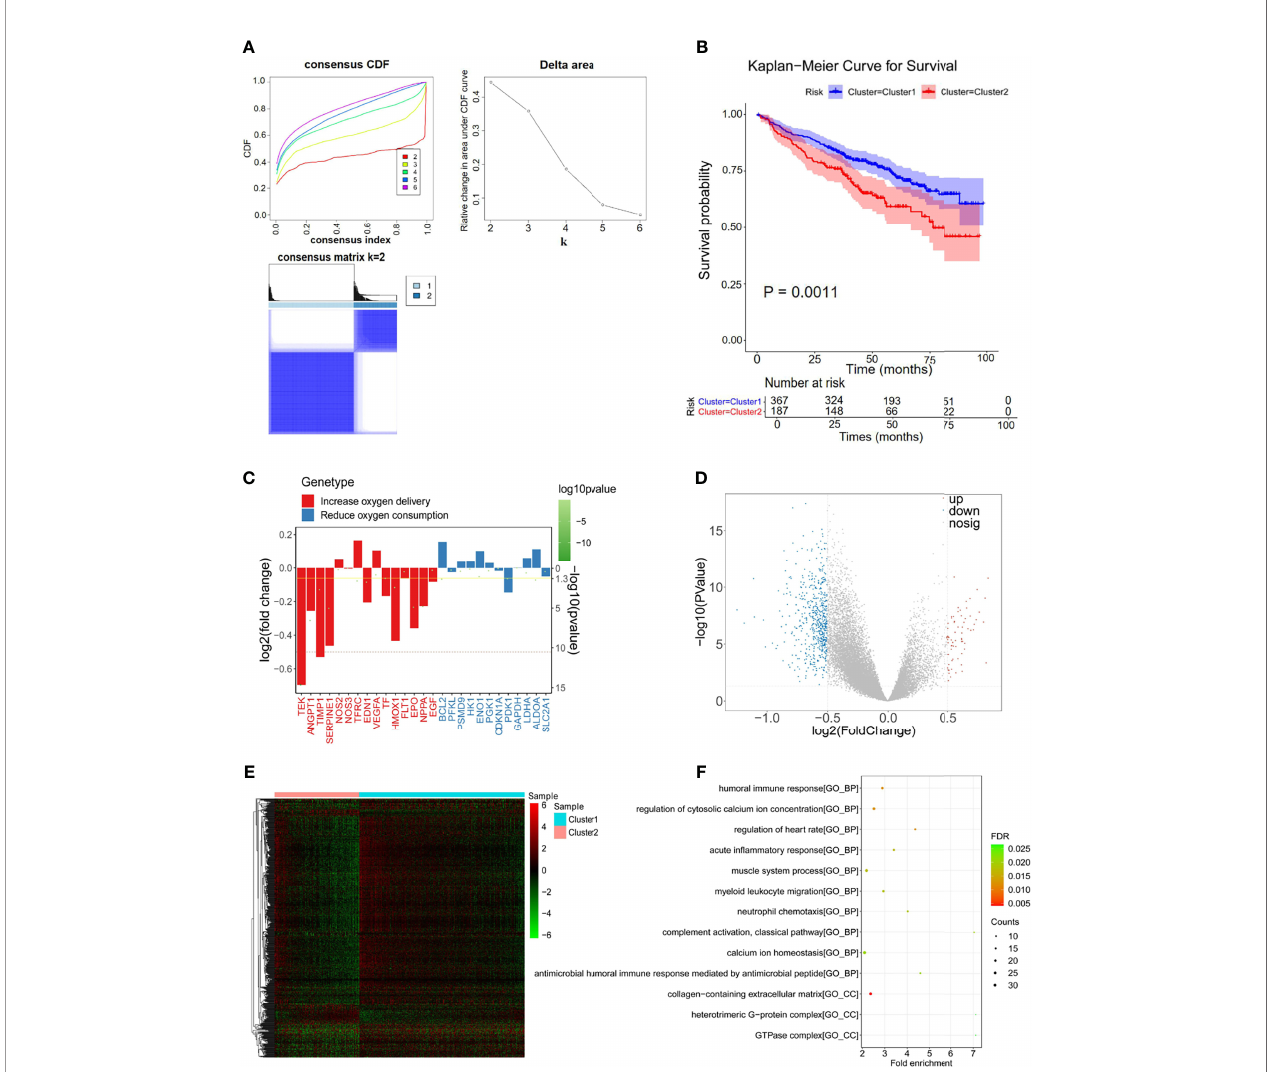
FIGURE 2 | Differentially expressed analysis of hypoxia-associated 639 genes for multiple myeloma (MM). (A) The Euclidean distance was used to calculate the similarity distance between MM samples, and the optimal number of the clusters was determined by the cumulative distribution function (CDF). (B) Kaplan – Meier analysis of the different clusters to predict the survival of the patient. Upper: Kaplan – Meier curve of the overall survival between clusters 1 and 2 groups. Lower: the number of patients at risk in clusters 1 and 2 groups at different time points. (C) Identi fi ed the hypoxia status between the two clusters by analyzing the target gene expression changes of the HIF-1 signaling pathway. (D , E) In total, 639 hypoxia-related differentially expressed genes (DEGs) were identi fi ed with hierarchical cluster analysis for MM. (F) Functional enrichment analysis of the 639